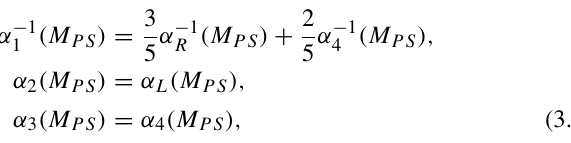
TeV in Fig. 1, where the solid (dashed) lines correspond to m T , 45 , 126 = 10 5 ( 10 7 ) TeV. From top to bottom, the three solid/dashed lines denote α 1 , 2 , 3 for μ < M PS and < μ < M = 10 5 ( 10 7 ) α R , L , 4 for M PS GUT . For m T TeV, we find M PS (cid:3) 3 . 5 × 10 8 ( 2 . 5 × 10 10 ) GeV and M GUT (cid:3) 8 . 8 × 10 17 ( 2 . 2 × 10 16 )